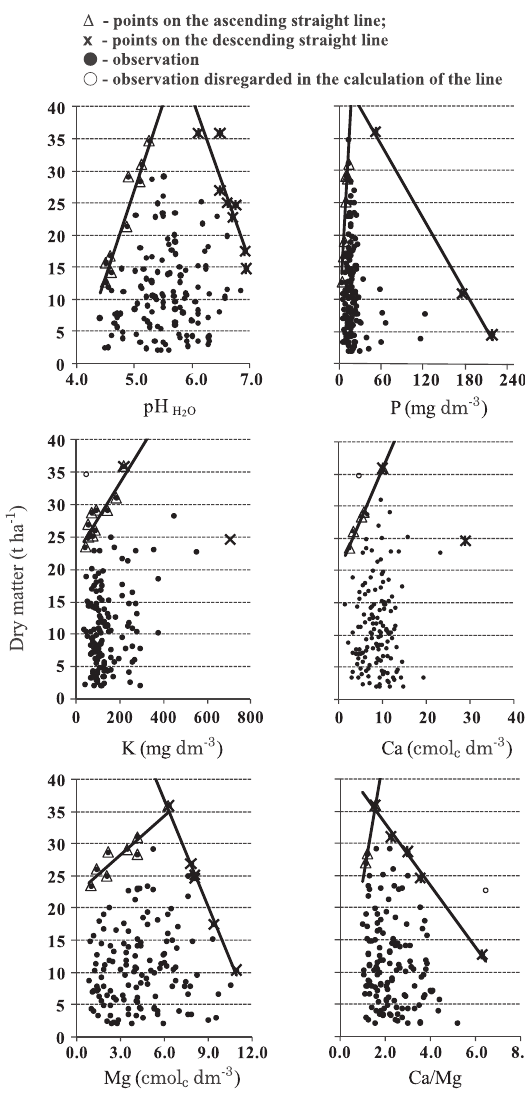
figure 2. Relationship between the yields of Salix x rubens and the ph values, exchangeable contents of P, K, ca, and mg and the ca/mg ratio of the soil on the Southern Plateau